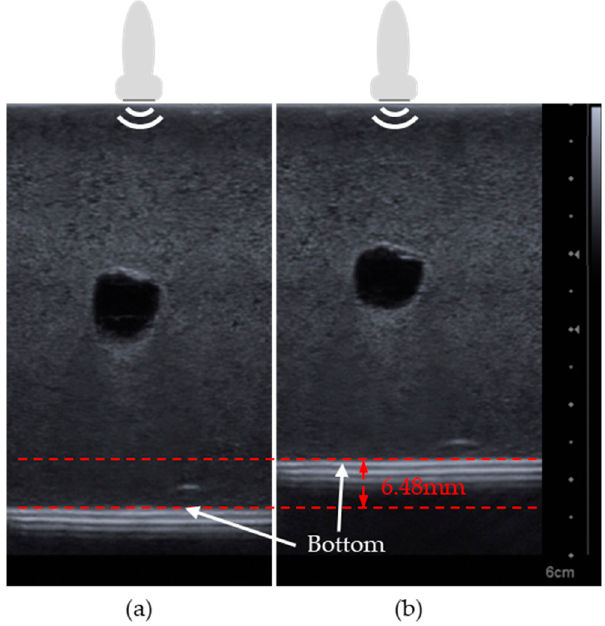
Figure 9. Ultrasound images of breast phantom ( a ) before and ( b ) after pressure is exerted. The scale bar is on the right side of the figure.